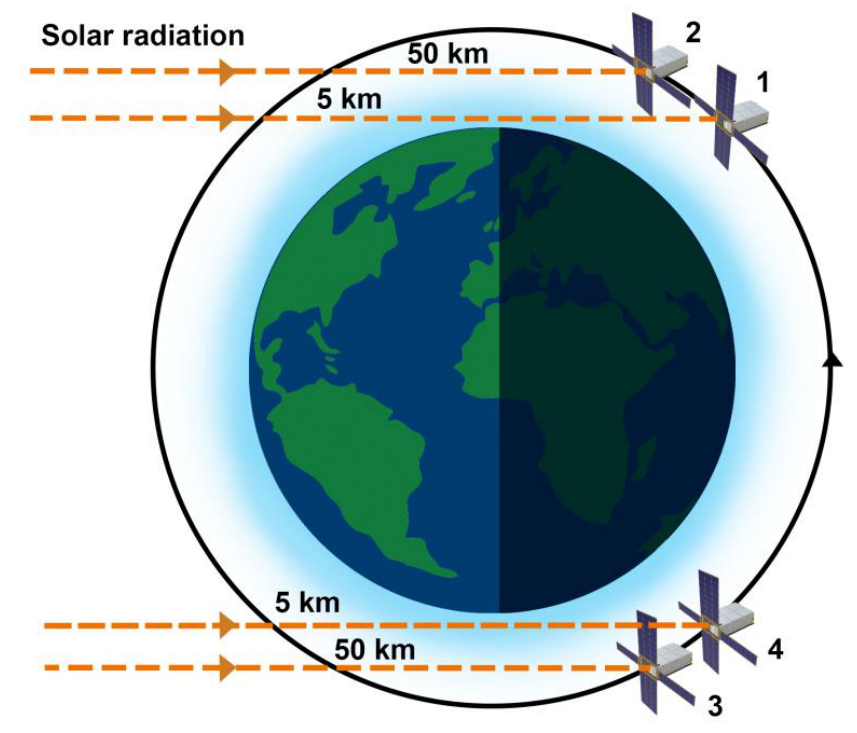
Figure 9. Solar occultation observation geometry for a spaceborne MLHS.